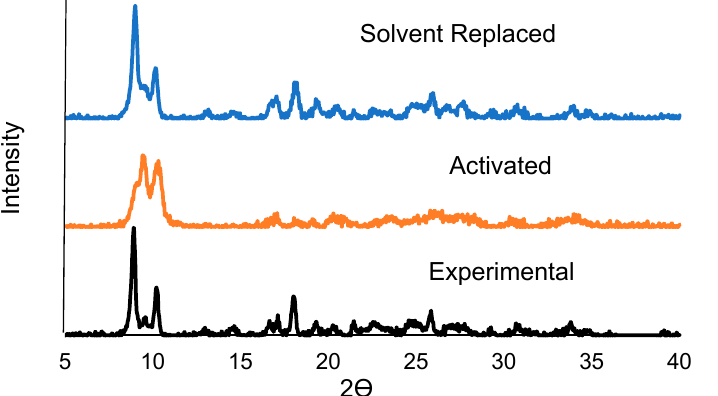
Figure 5. The comparison of the PXRD of the experimental, activated sample (423 K), and the solvent replaced for compound 2 .